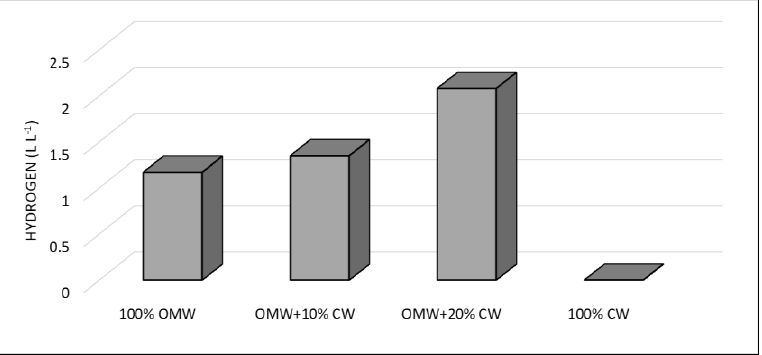
Figure 4. Hydrogen yield of experiments conducted using the F/M ratio of 2.5 g SV g SV −1